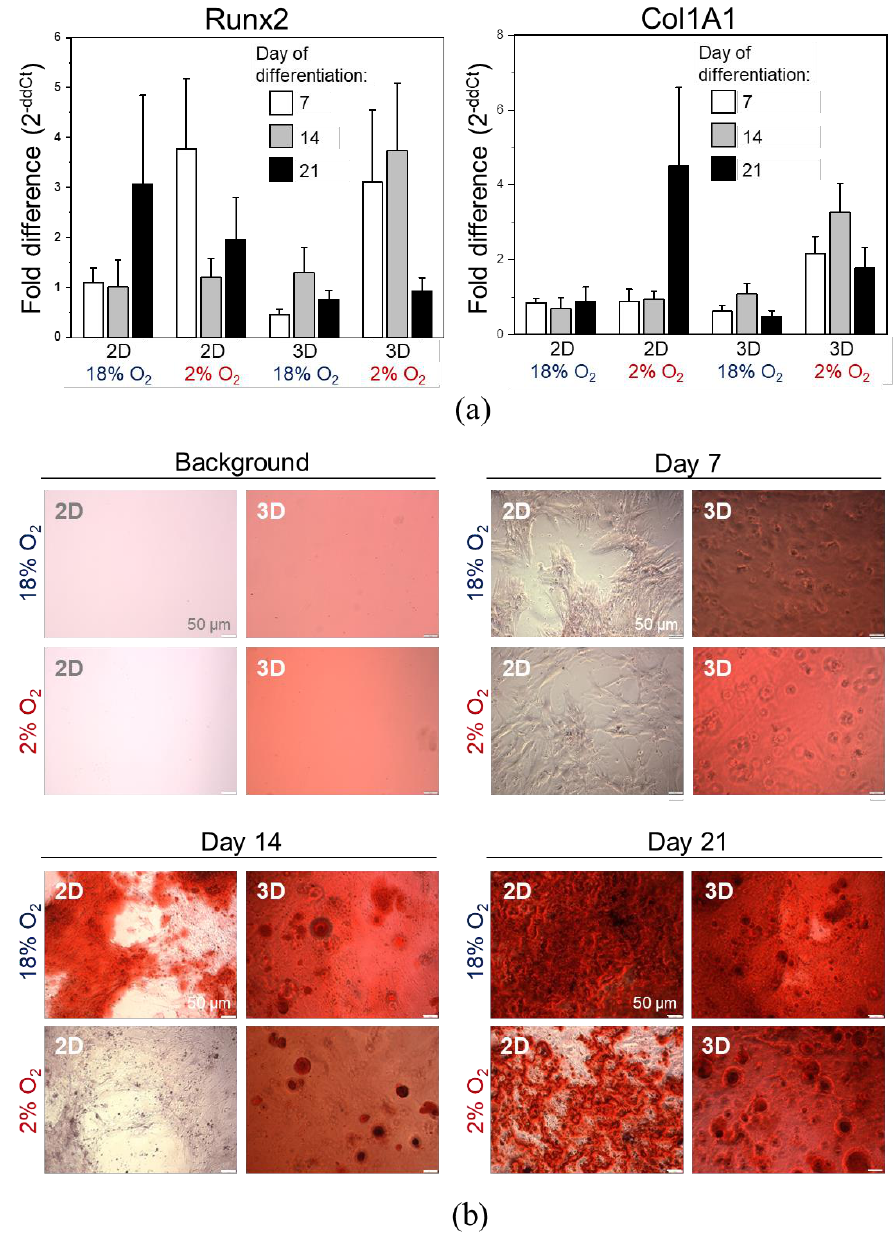
Figure 8. Osteogenic differentiation of DPSCs encapsulated in hydrogel (3D) or seeded on the surface coated with gelatin (2D) cultured in hypoxic (2% O 2 ) or normoxic (about 18% O 2 ) environment. ( a ) Quantitative analysis of mRNA expression for osteogenesis associated genes ( Col1A, Runx2 ) in DPSCs on days 7, 14, and 21 of differentiation. Fold change in the expression of analysed genes in control cells before differentiation was calculated as 1.0 and marked by a solid line. Results are presented as mean ± SEM, n = 3 (every sample was analysed in duplicate). p < 0.05 ( t -test). ( b ) Representative images of DPSCs differentiated into osteoblasts on days 7, 14, and 21 days of differentiation. Panel “Background” contains the representative images of 2D and 3D surfaces (standards plastic dish and hydrogel without cells, respectively) stained with Alizarin Red S solution to visualize background staining (on day 7 post surface preparation). Panels “Day 7”, “Day 14”, “Day 21” demonstrate representative images of DPSCs cultured in StemPro osteogenesis differentiation kit. On days 7, 14